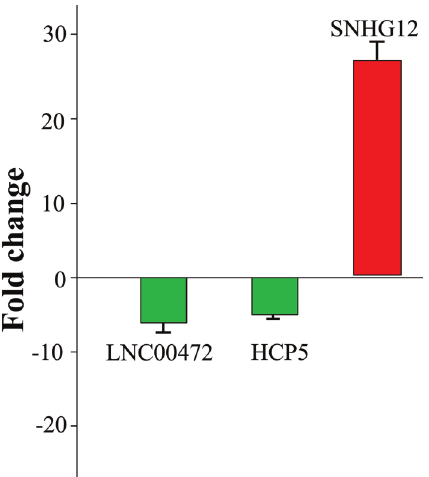
Figure 7. Fold change (2- DD Ct ) of 3 key lncRNAs by qRT-pCR. The primer targeting beta-actin mRNA was used as internal control. Green represents down-regulation, while red represents up-regulation. Data are reported as the mean fold-change ± SE of lncRNAs expression in tumor samples relative to normal